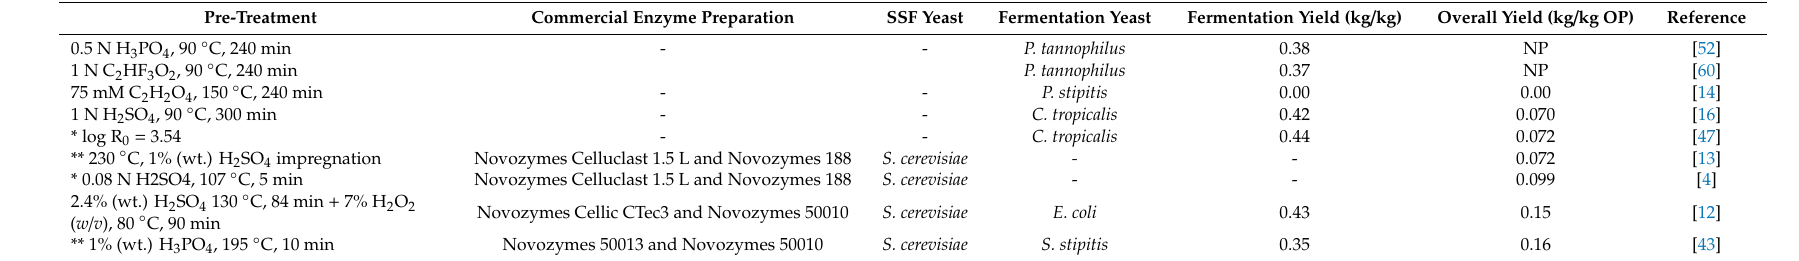
Table 6. Ethanol yields obtained from olive-pruning debris (OP) using di ff erent hydrolysis plus fermentation